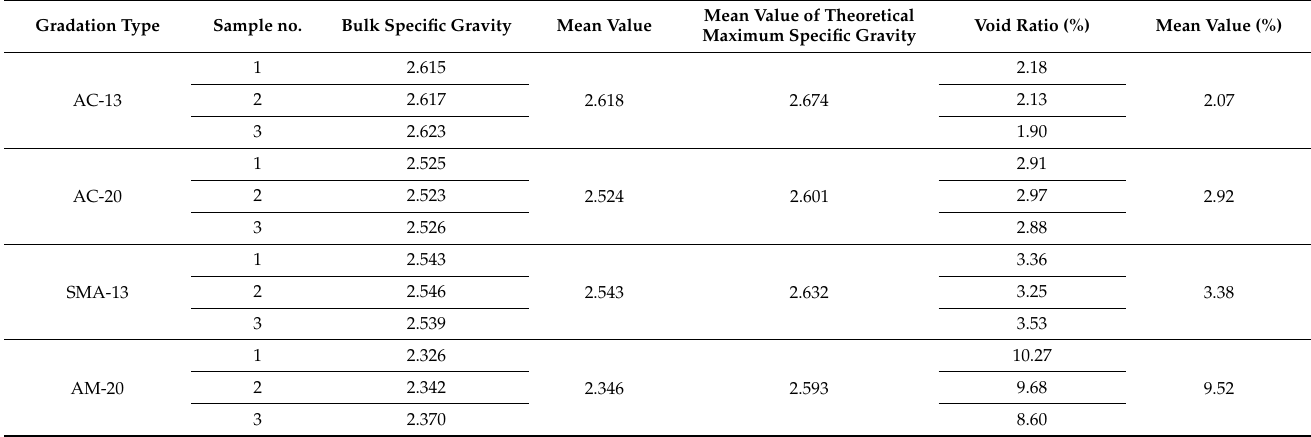
Table 3. Physical properties of asphalt